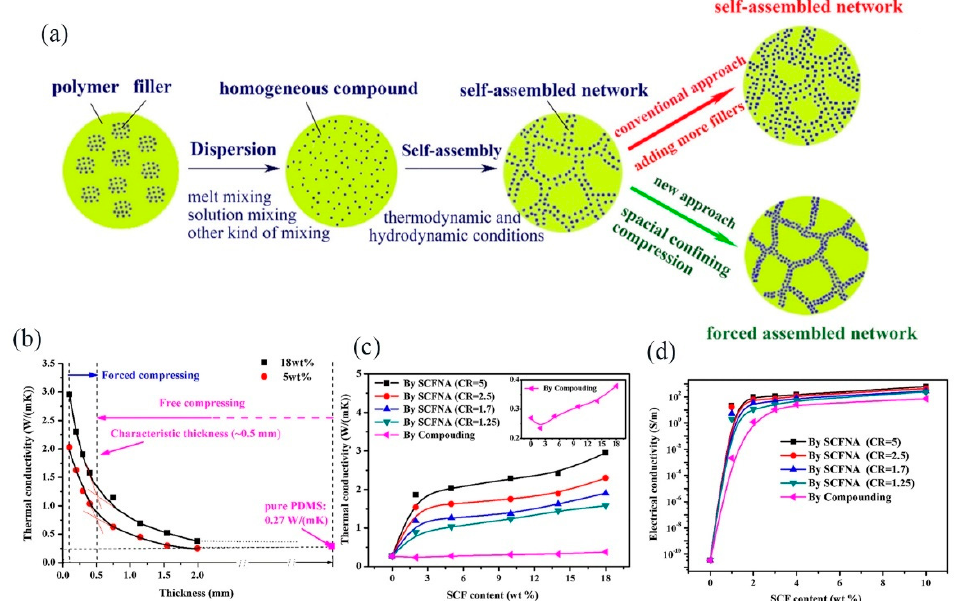
Figure 9. ( a ) Scheme of technological pathway of spatial confining forced network assembly (SCFNA) method and conventional compounding. ( b ) λ of PDMS/short-carbon-fiber (SCF) composites with different thicknesses. ( c ) The thermal and ( d ) electrical conductivity of PDMS/SCF composites [131]. Table 4. λ of carbon fiber / polymer